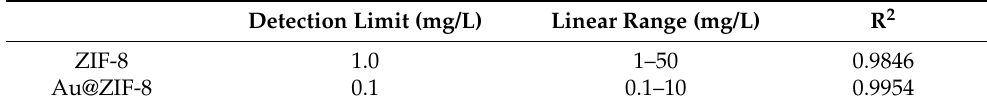
Table 1. Comparison with the SERS effect between ZIF-8 and Au@ZIF-8.